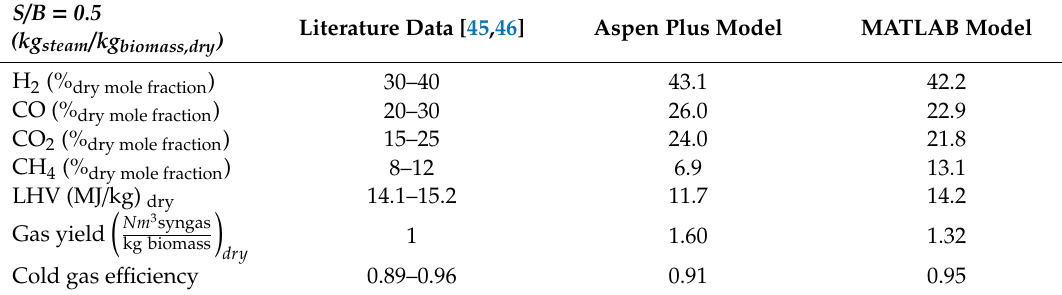
Table 4. Comparison of syngas composition and characteristics (S / B = 0.5).